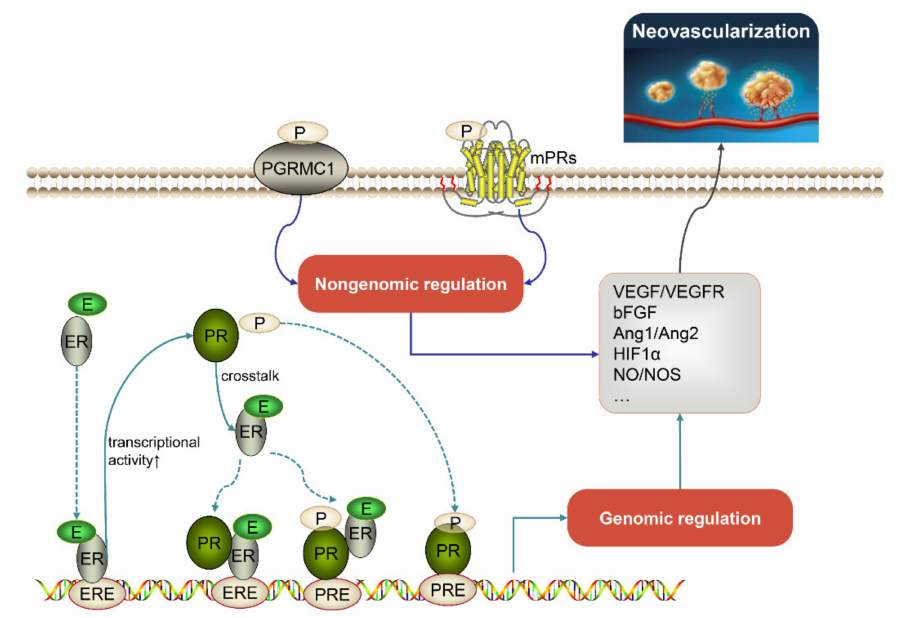
Figure 2. Genomic and nongenomic signaling pathways of progesterone that contribute to regulation of neovascularization. Ang1: angiopoietin1; Ang2: angiopoietin2; bFGF: basic fibroblast growth factor; E: estradiol; ER: estrogen receptor; ERE: estrogen response element; HIF1 α : hypoxia inducible factor 1 α ; P: progesterone; PGRMC1: progesterone membrane component 1; PR: progesterone recep- tor; PRE: progesterone response element; NO: nitric oxide; mPRs: membrane progestin receptors; NOS: nitric oxide synthase; PD-ECGF: platelet-derived endothelial cell growth factor; VEGF: vascular endothelial growth factor; VEGFR: vascular endothelial growth factor